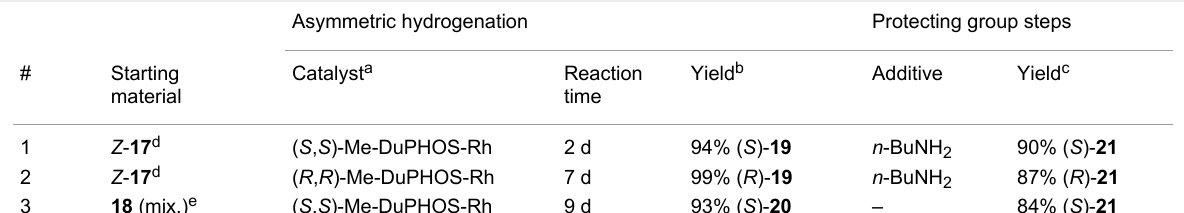
Table 1: Reactions from 17 and 18 to 21 (see Scheme 2). Asymmetric hydrogenation Protecting group steps Starting Catalyst a Reaction Yield b material time